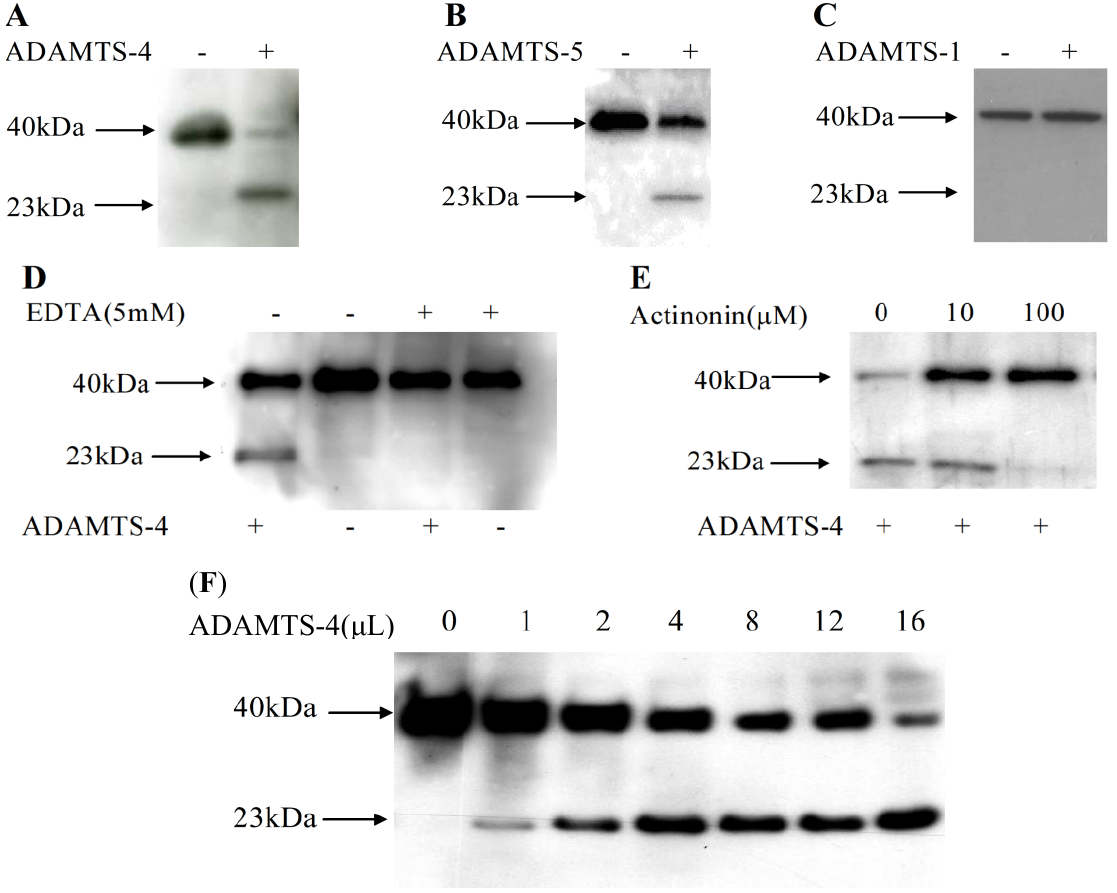
Figure 2. Matrilin-2 was cleaved by purified human ADAMTS-4 and ADAMTS-5 specifically. Matrilin-2 peptides were incubated with or without purified recombinant ADAMTS-4 ( A ), ADAMTS-5 ( B ) and ADAMTS-1 ( C ). Western blot analysis of the conditioned medium of Cos-1 cells was performed using an anti-FLAG polyclonal antibody. EDTA ( D ) or actinonin ( E ) was added into cell culture. These conditioned media were incubated with or without purified recombinant ADAMTS-4 followed by western blot analysis with an anti-FLAG polyclonal antibody. ( F ) ADAMTS-4 cleavage of matrilin-2 was dosage dependent. Purified M2L (1 ng) in 10 μ L reaction buffer was incubated with purified human recombinant ADAMTS-4 (5 μ g/25 μ L) at the contents of 0, 1, 2, 4, 8, 12, and 16 μ L at 37 °C for 24 h, followed by western blot analysis using anti-flag poly clonal